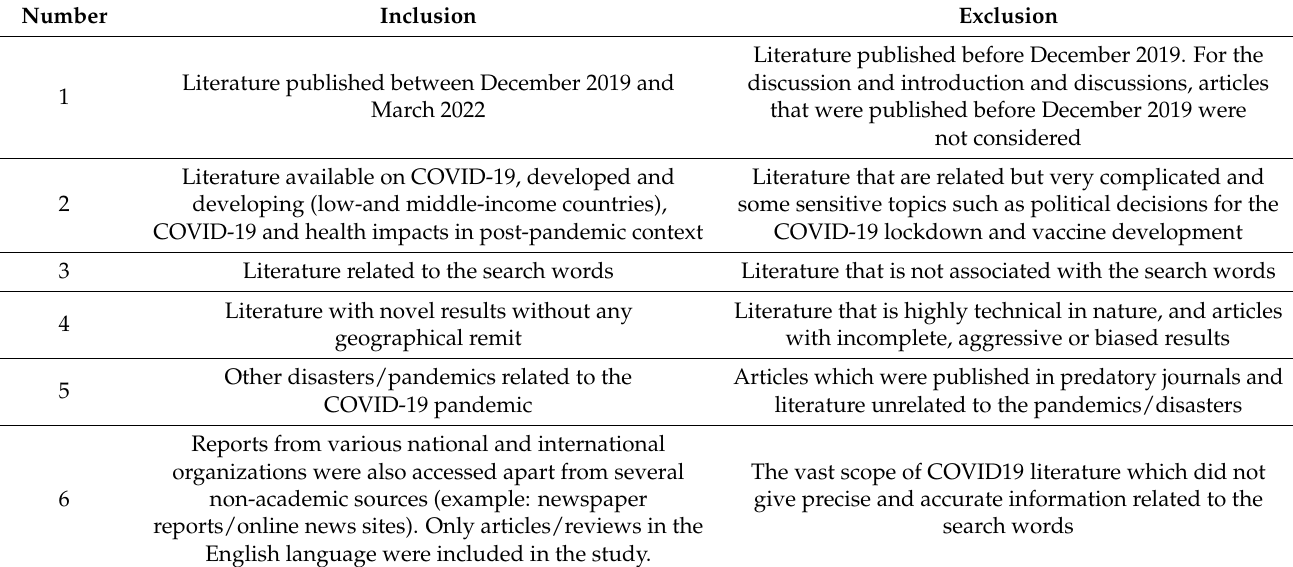
Table 1. Criteria for the inclusion and